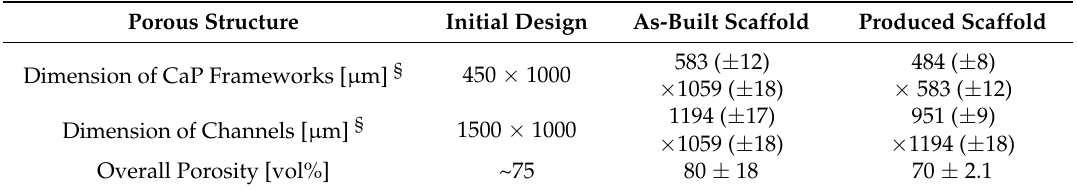
Table 1. The dimensions of the CaP filaments and channels in the x–z direction and the overall porosity of the designed scaffold, as-built scaffolds and produced scaffolds after sintering at 1250 °C for 3 h.